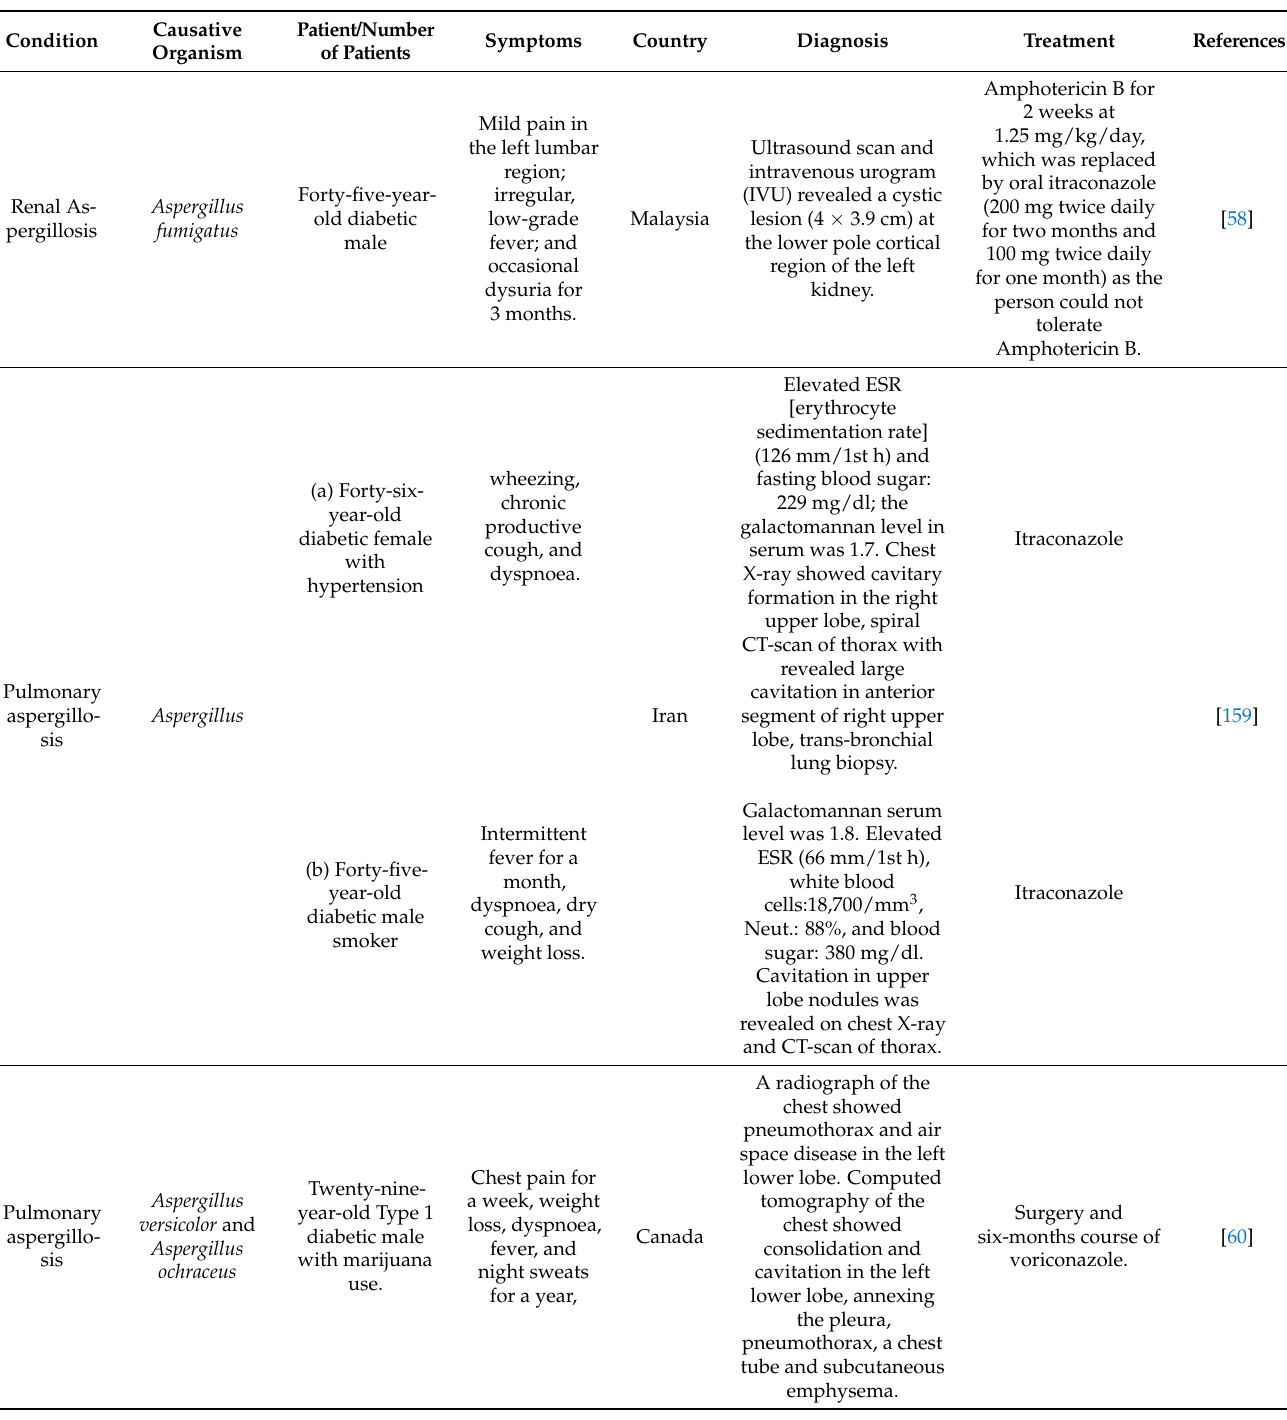
Table 1. Recent studies on aspergillosis cases with diabetic